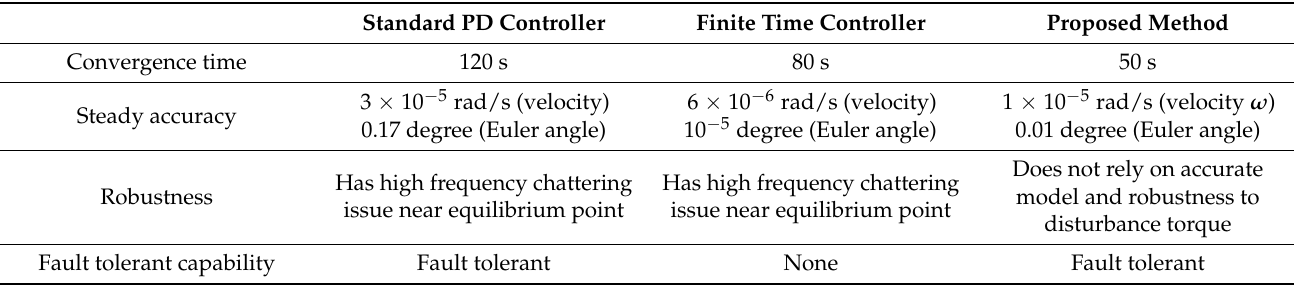
Table 1. Comparison of the proposed method and existing